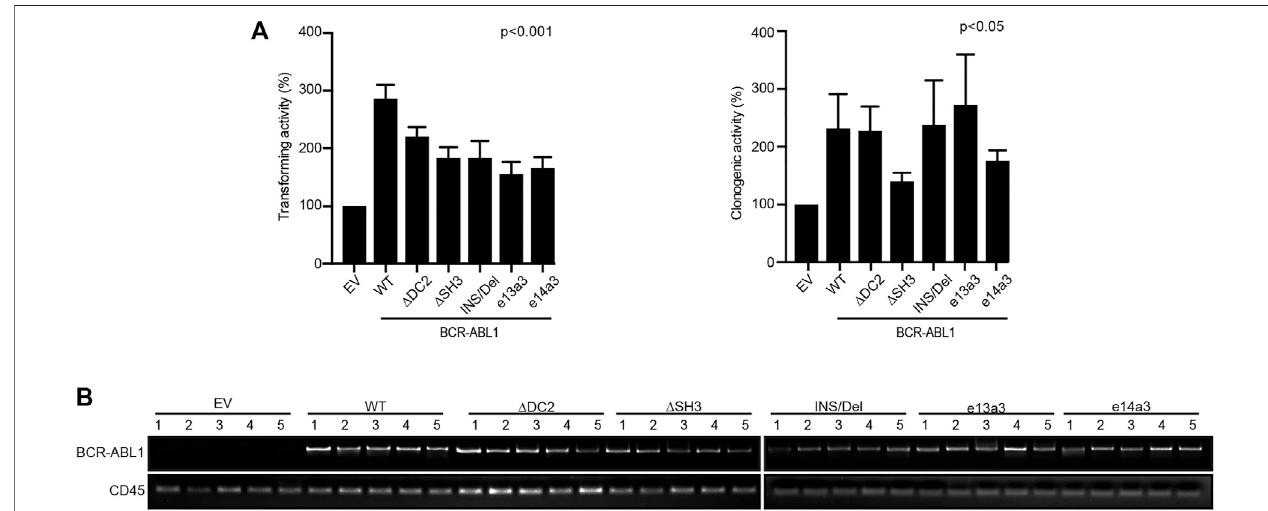
FIGURE 5 | Uncommon fusion transcripts modify BCR-ABL1 transforming ability and clonogenic potential. (A) Histograms show the percentage of transforming ability(I)andclonogenicpotential(II)oftheindicatedconstructslentivirallyexpressedinhumanCD34-positivecellscomparedtotheemptyvectorconditionarbitrarilyset at 100%. Bars indicate the standard deviation of two experiments performed in duplicates. (B) RT-PCR performed on total RNA extracted from fi ve single colonies plucked after 15 days of growth in methylcellulose. CD45 was used as an RNA integrity control.